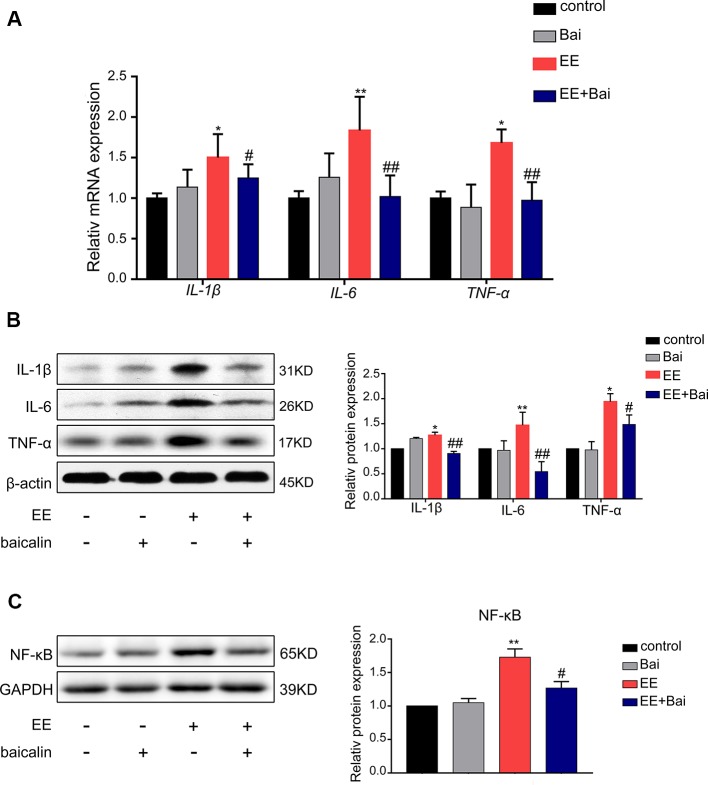
Baicalin decreased the level of inflammatory factors through the NF-κB pathway in the liver. (A) The mRNA level of IL-1β, IL-6, and TNF-α in rat liver. (B) The protein expression of IL-1β, IL-6, and TNF-α in rat liver. (C) The protein expression of NF-κB in rat liver. Data are presented as the mean ± SD (n = 6). *p < 0.05 and **p < 0.01 versus the control group, #p < 0.05 and ##p < 0.01 versus the EE group.